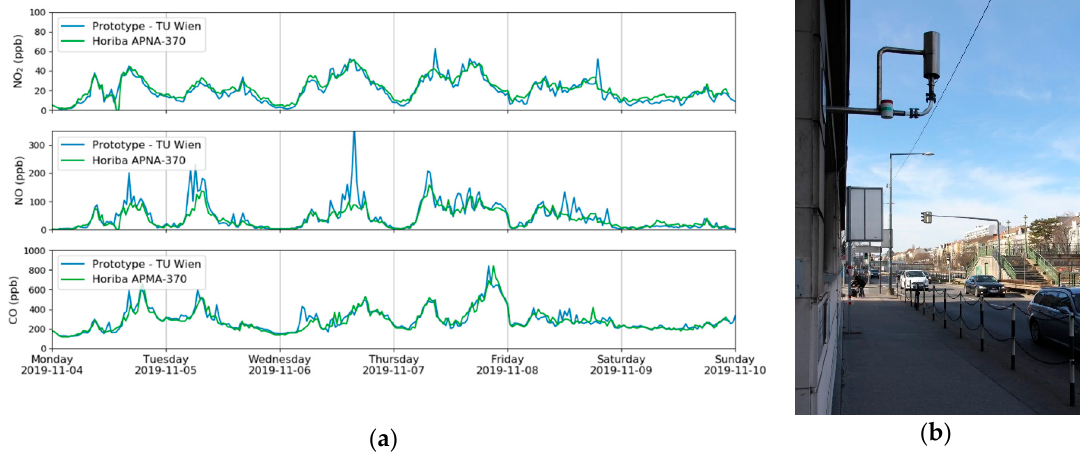
Figure 6. Time series of CO, NO and NO 2 during one week of the measurement campaign in Vienna. Beside data from the QCL sensor, values from the MA 22 are plotted too ( a ). The intake of the measurement station ( b ) is located close to an intersection of a busy road.